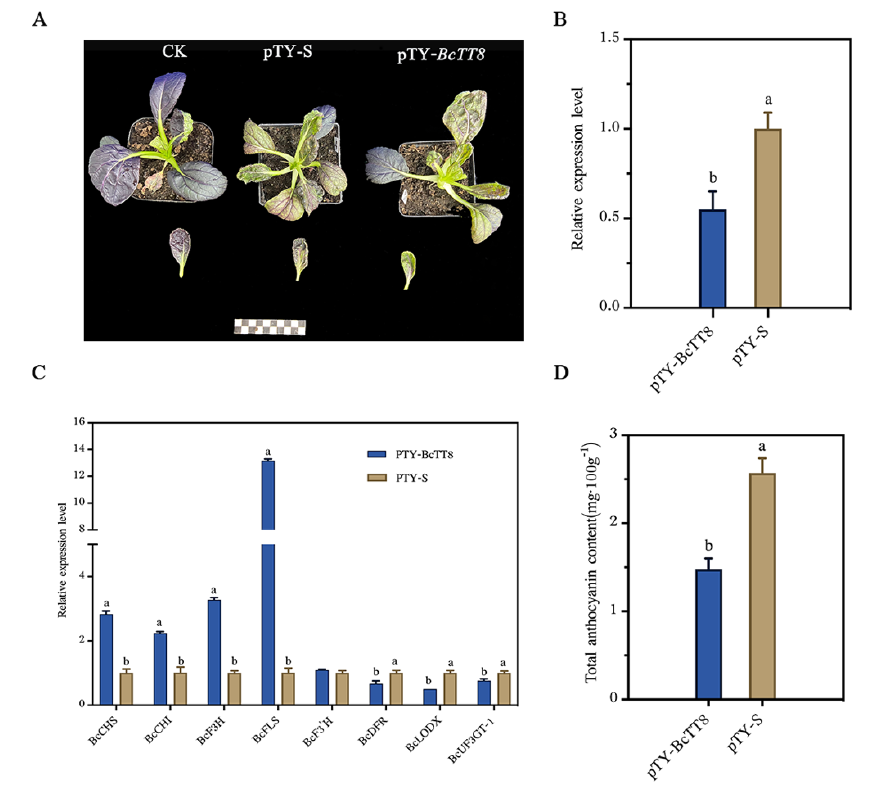
Figure 7. Photographs of WT, pTY-S and pTY- BcTT8 plants ( A ) and RT-qPCR analysis result of BcTT8 and anthocyanin pathway genes ( B , C ) and total anthocyanin content in plants ( D ). Significant differences ( p < 0.05) were indicated with different letters.